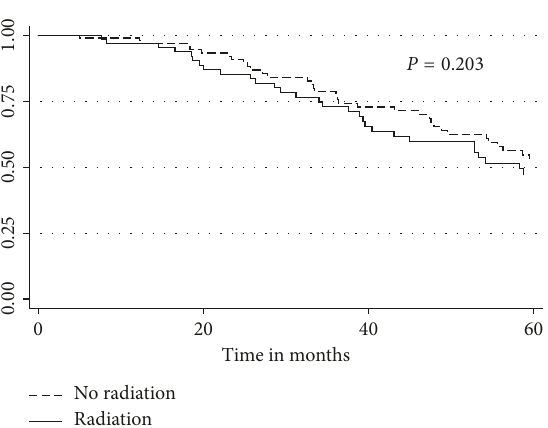
Figure 1: Kaplan–Meier overall survival curves for patients treated with surgery plus chemotherapy with and without radiotherapy.